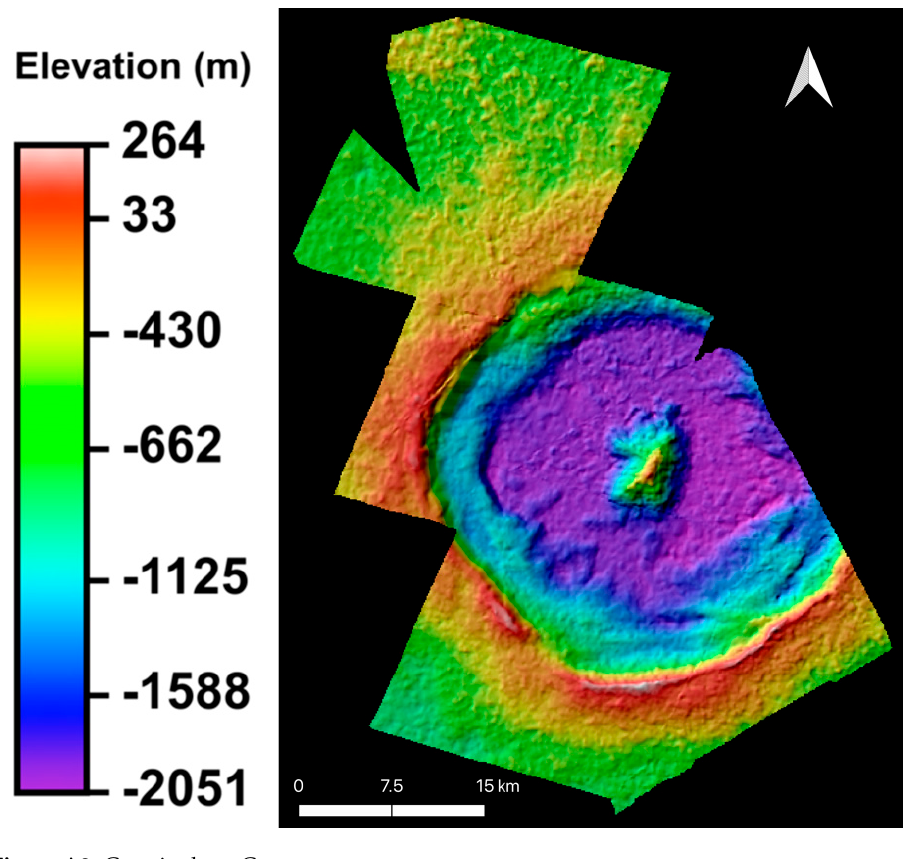
Figure A1. Vent in Catullus Crater.